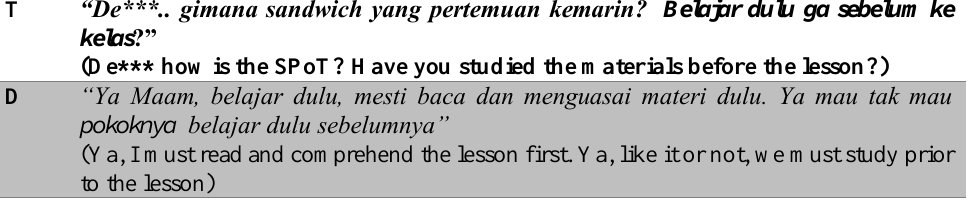
Table 5. Students’ perception of peer assessment